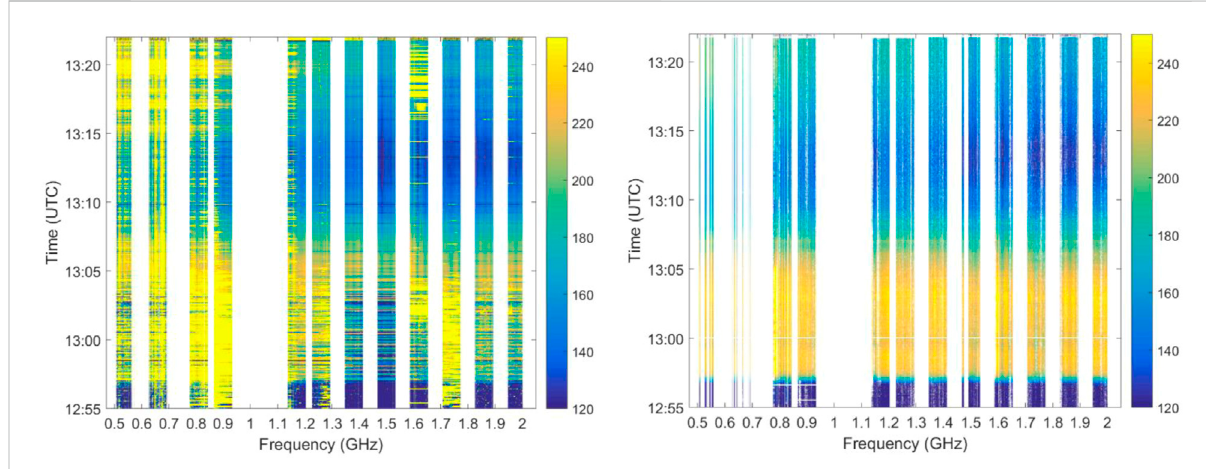
FIGURE 2 Pre(left)andpost(right)RFIprocessingfordatacollectedoverGreenland.Brightnesstemperatures(inKelvin)foreachfrequencybandarecolor coded (scale on the right of each fi gure) and plotted against time along the fl ight path. The difference between the two images shows that usable information can be obtained in post processing even in the low frequency channels that experience the most RFI contamination. The data gap at about 1 GHz coincides with the aircraft collision avoidance radar that would have saturated the radiometer (From Johnson et al.,